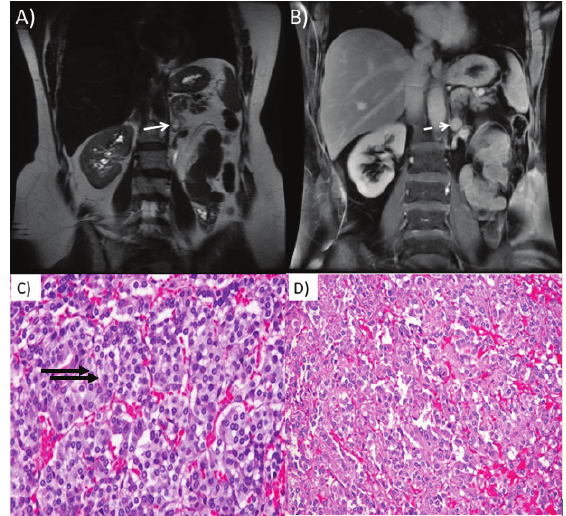
Figure 3. (A) Coronal Single-shot fast spin echo (SSFSE) image of the abdomen shows a high signal lesion (white arrow) within the medial limb of the left adrenal gland. (B) Coronal T1 post- contrast image shows a homogeneously enhancing mass (dashed white arrow) consistent with pheochromocytoma. (C) and (D) Hematoxylin-eosinstainingshowingnestsoftumorcells(zellbal- len growth pattern) surrounded by a discontinuous layer of sus- tentacular cells and fi brovascular stroma intermixed with